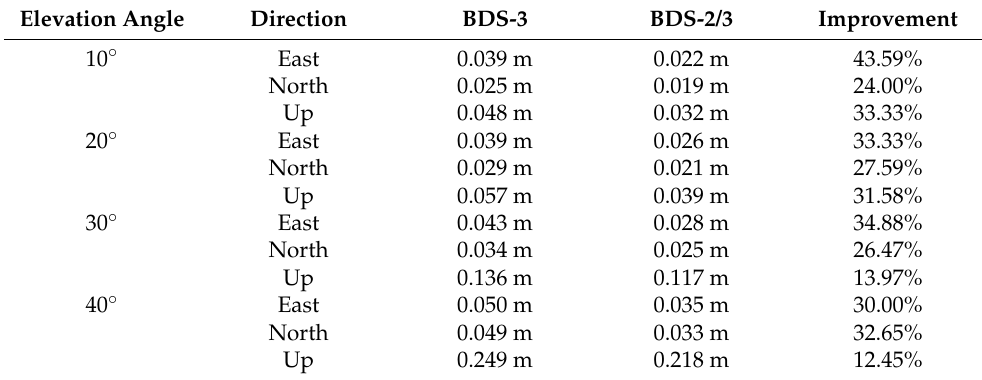
Figure 4. The positioning errors in E, N, U directions at JFNG, NNOR, MIZU, SGOC, and IISC stations. Table 5. Medians of the positioning errors (m) at different cut-off elevation angles.